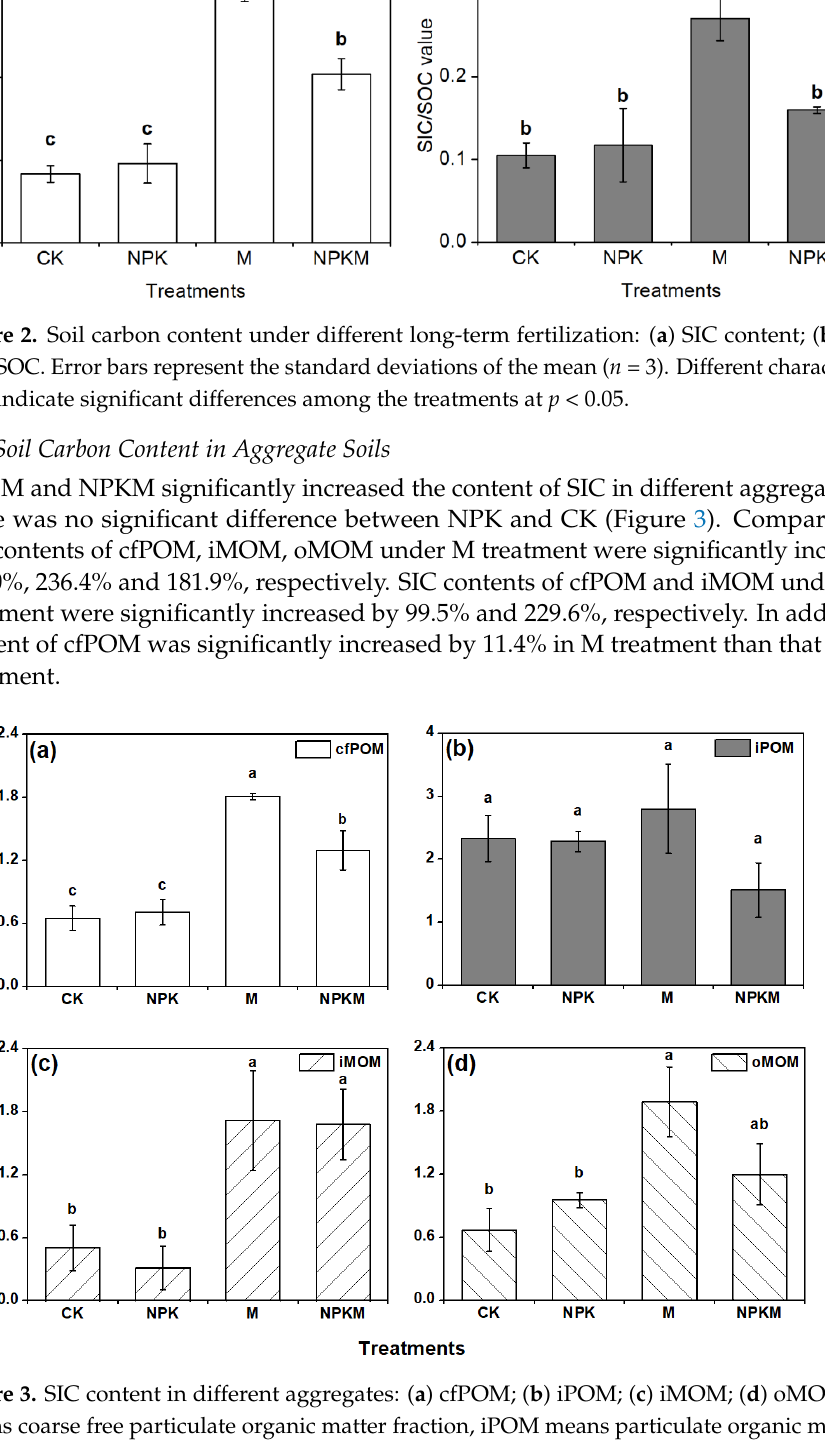
Figure 4. The value of SIC/SOC in different aggregates: ( a ) cfPOM; ( b ) iPOM; ( c ) iMOM; ( d ) oMOM. cfPOM means coarse free particulate organic matter fraction, iPOM means particulate organic